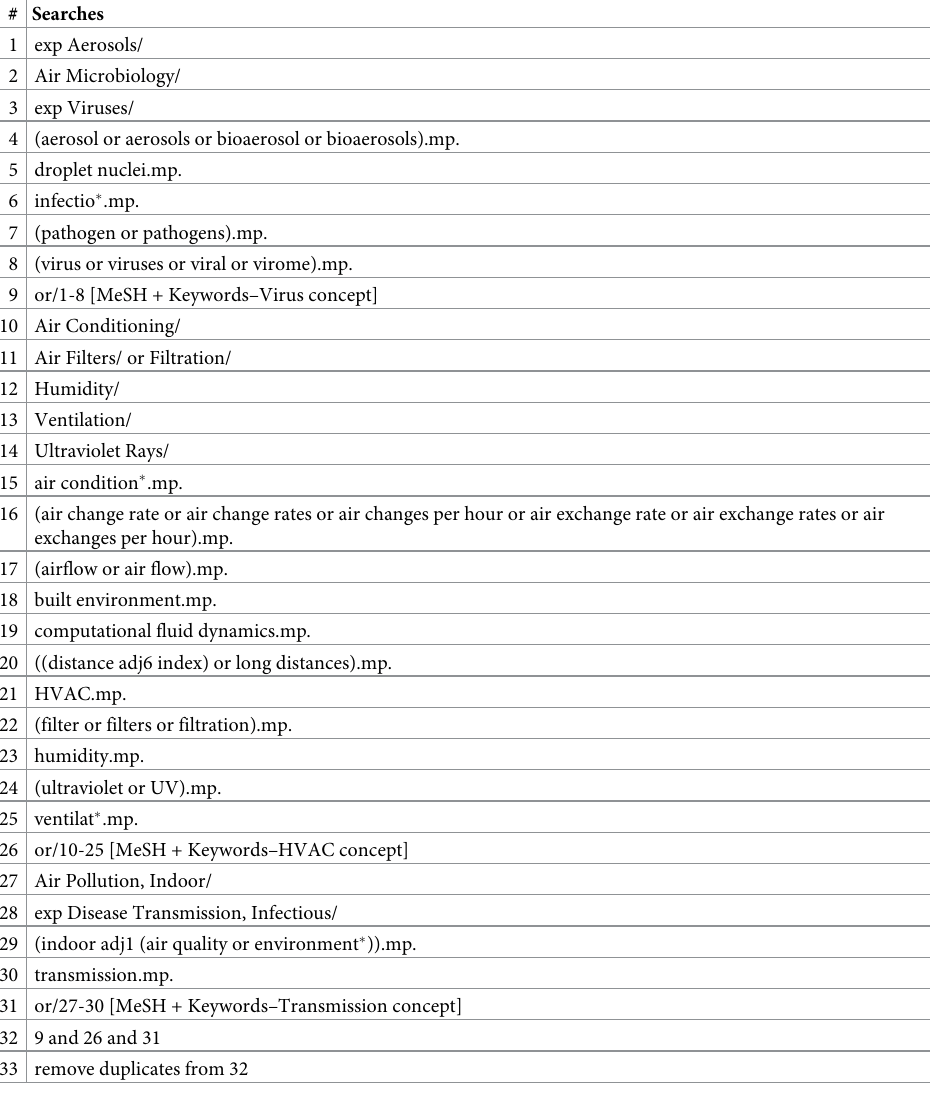
Table 1. Search strategy for Ovid MEDLINE ALL 1946 to Present 13